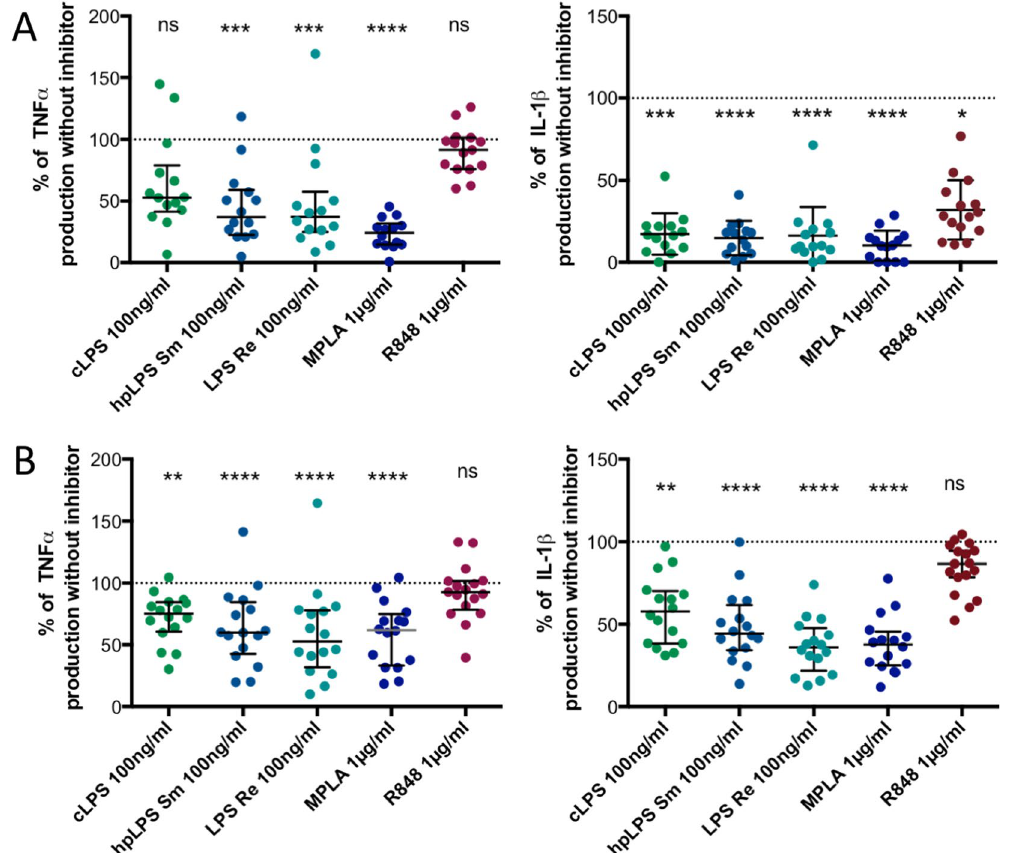
Figure 7. ( A ) Inhibition of TNF and IL-1 β production by pan-caspase inhibitor (Z-VAD 20 µ M) of human adherent mononuclear cells activated by either conventional smooth E. coli O111:B4 LPS (cLPS) (100 ng/ ml), highly purified S. abortus equi LPS (hpLPS) (100 ng/ml), highly purified rough S. minnesota LPS (ReLPS) (100 ng/ml) or MPLA (1 µ g/ml) for different donors. ( B ) Similar experiments performed in the presence of IL- 1Ra (100 µ g/ml). Each dot represents one individual donor. Neither Z-VAD nor IL-1Ra affected the cytokine production in the absence of agonists (data not shown). Results are expressed as percent of the individual responses in the absence of inhibitors. * p < 0.5; ** p < 0.01; *** p < 0.001; **** p <